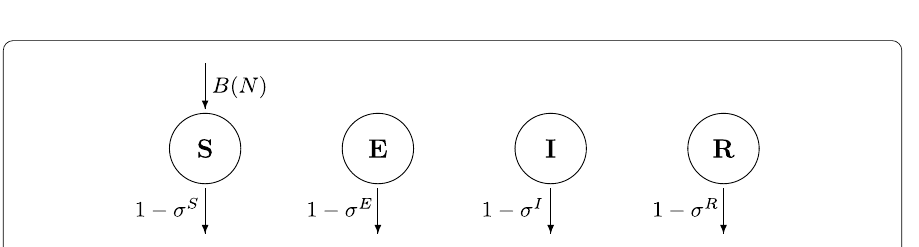
Figure 2 Demography flowchart of SEIRS epidemic model